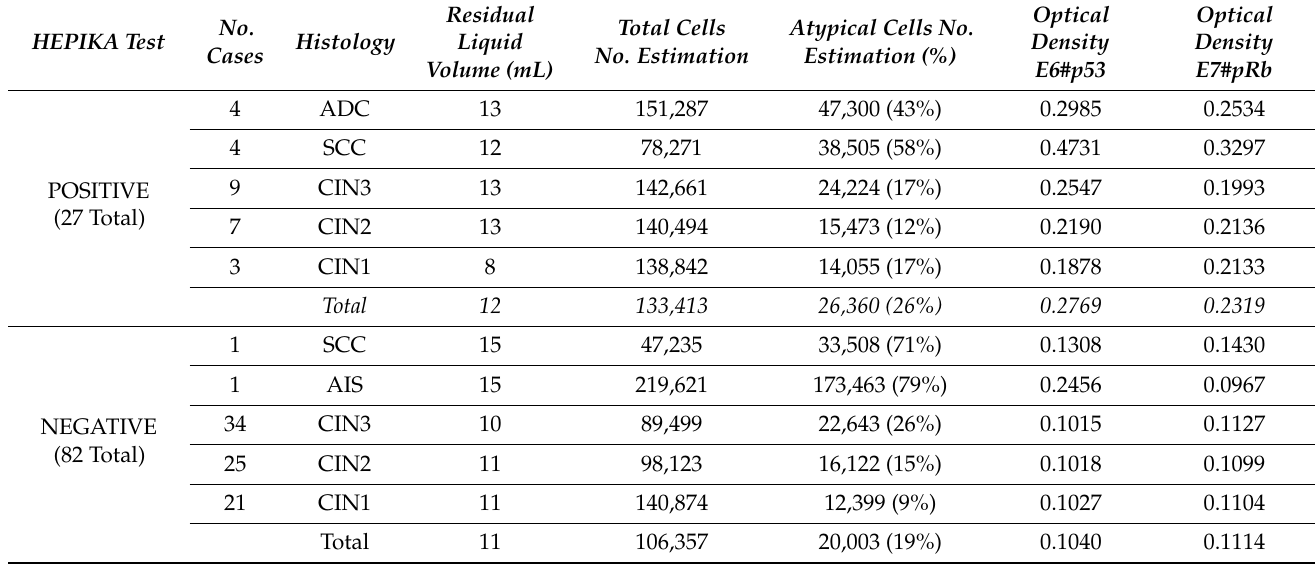
Table 2. Mean values of detections in 109 samples based on Hepika test and